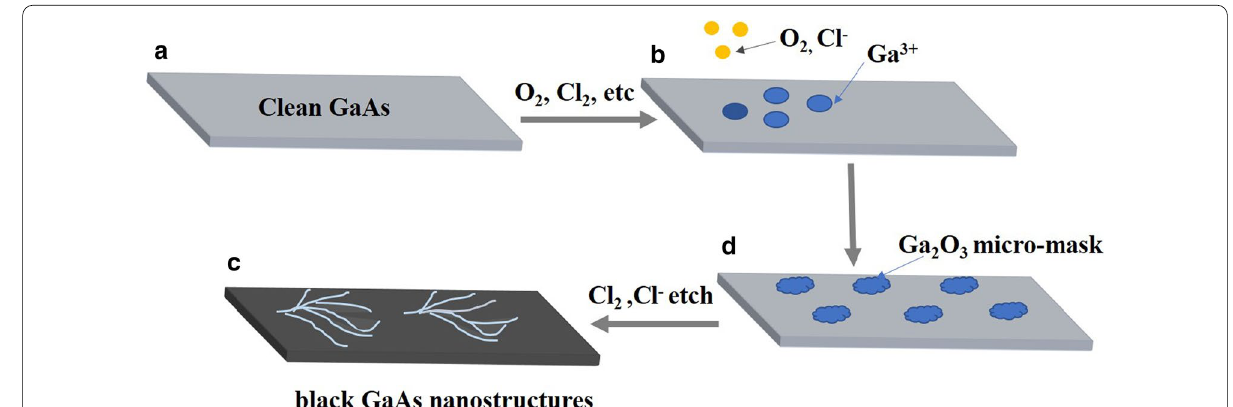
Fig. 2 Schematic view of black GaAs nanostructure formation in plasma. a Clean GaAs; b random etching of the native oxide; c forming micro-mask; d forming black GaAs nanostructures